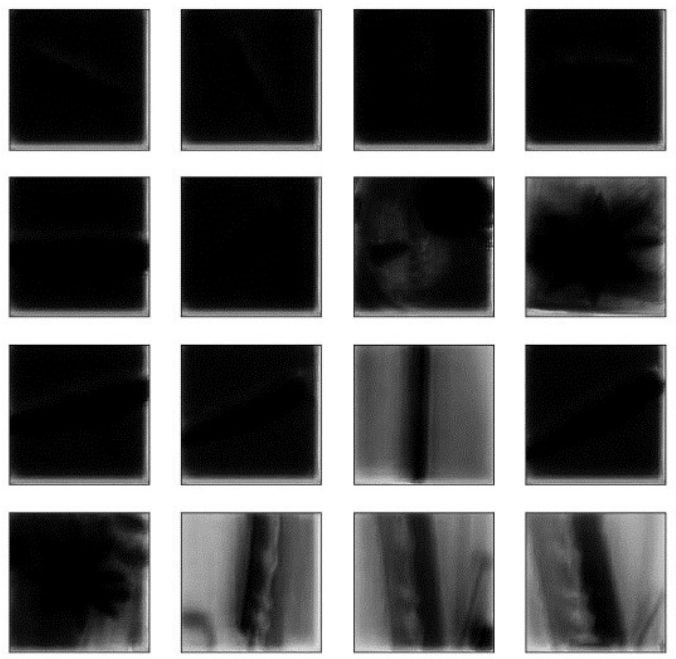
Figure 5. Image generated using ReLU activation layer after Epoch 1.